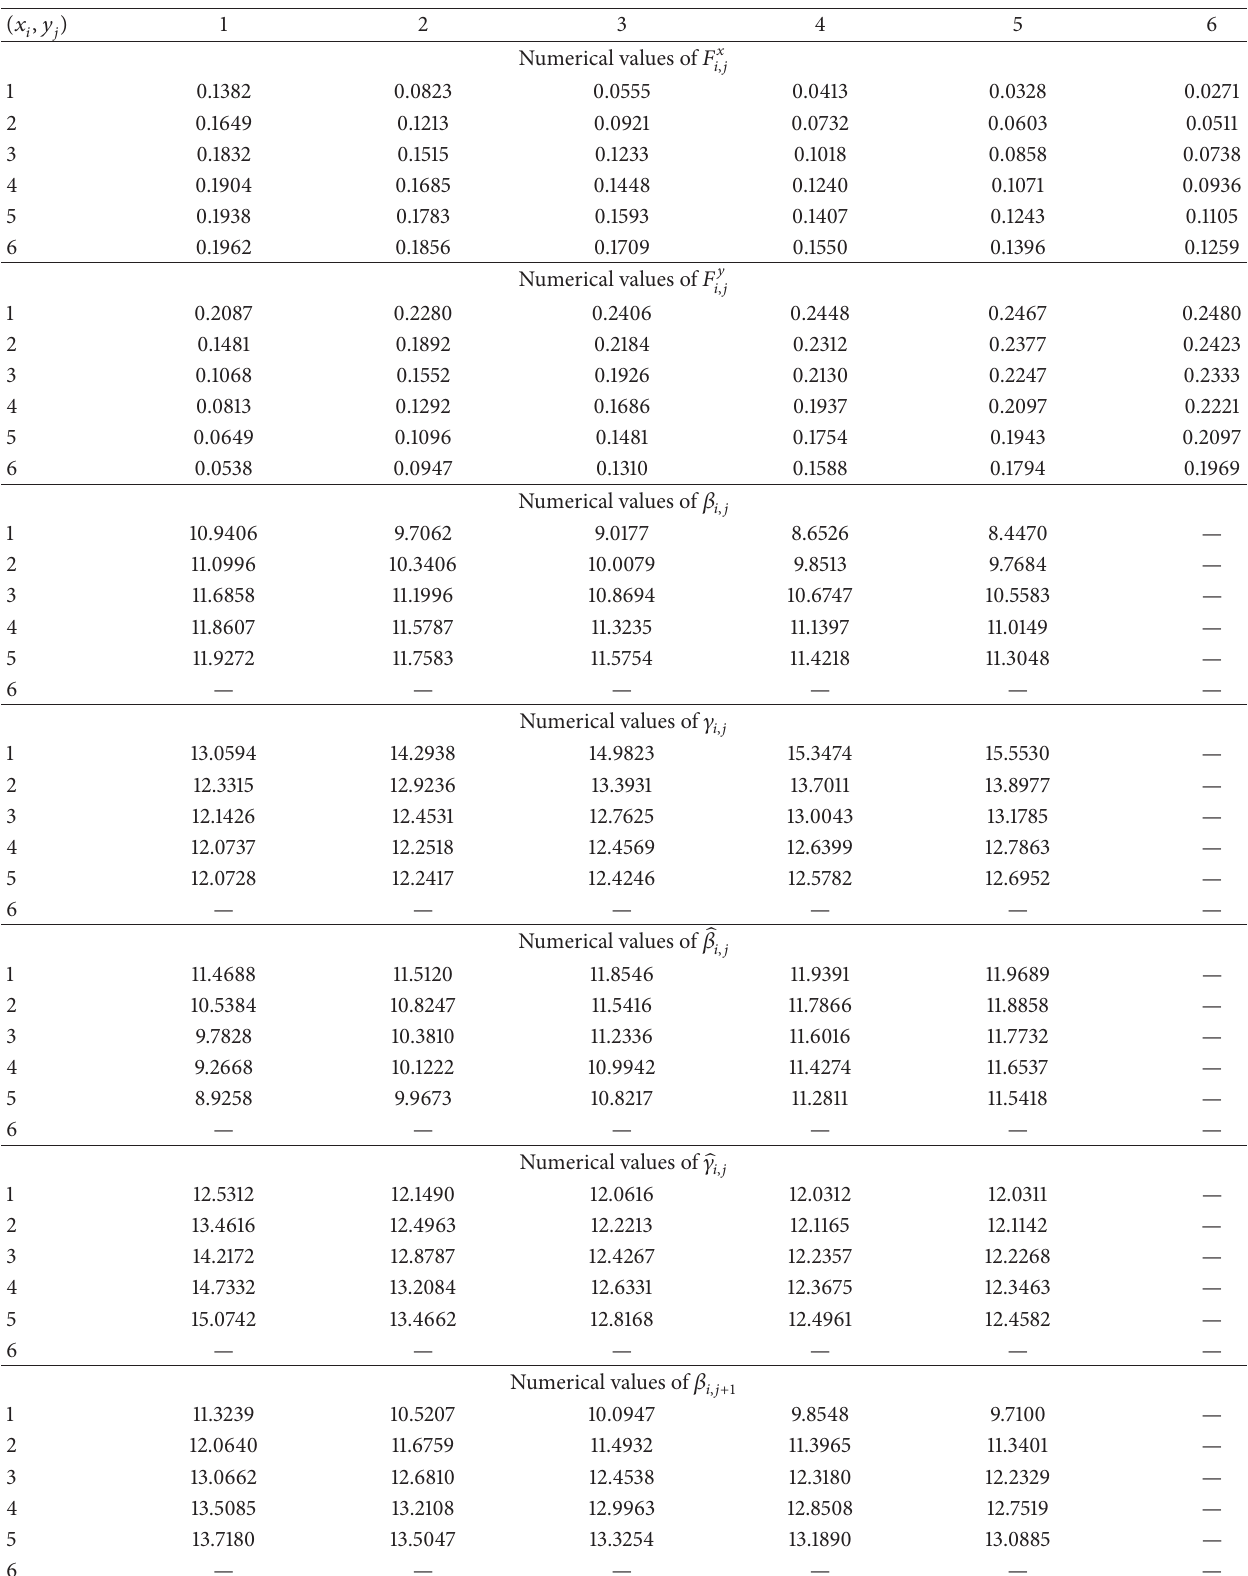
Table 7: Numerical values corresponding to Figure